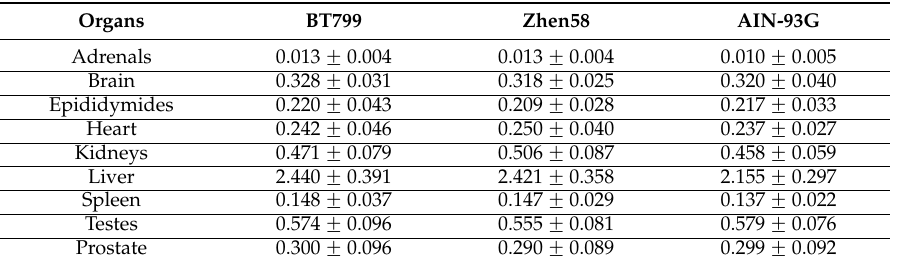
Table 8. Organ/body weight.